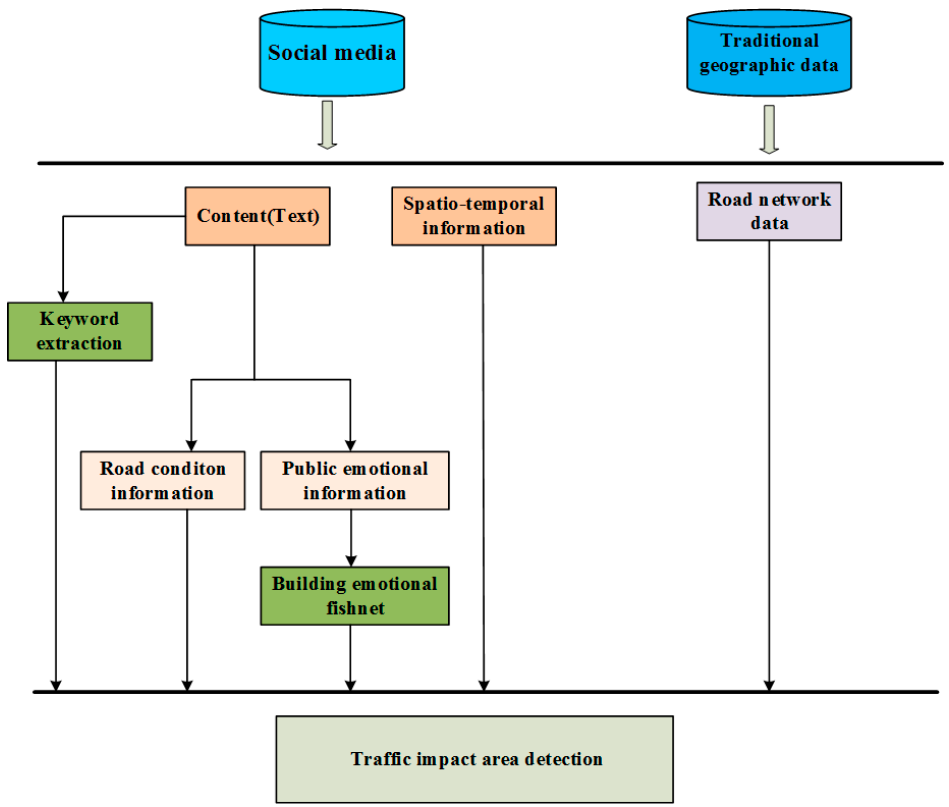
Figure 2. Workflow of the data processing.